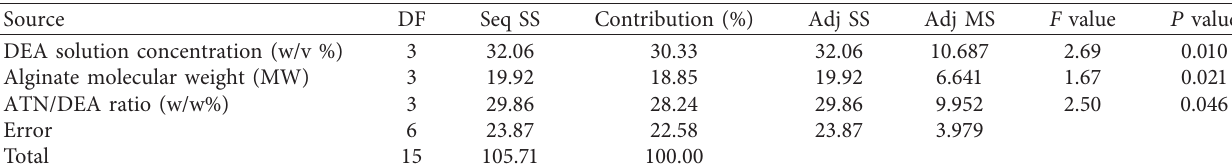
Figure 6: Probability plot for zeta potential. Table 8: Analysis of variance for zeta